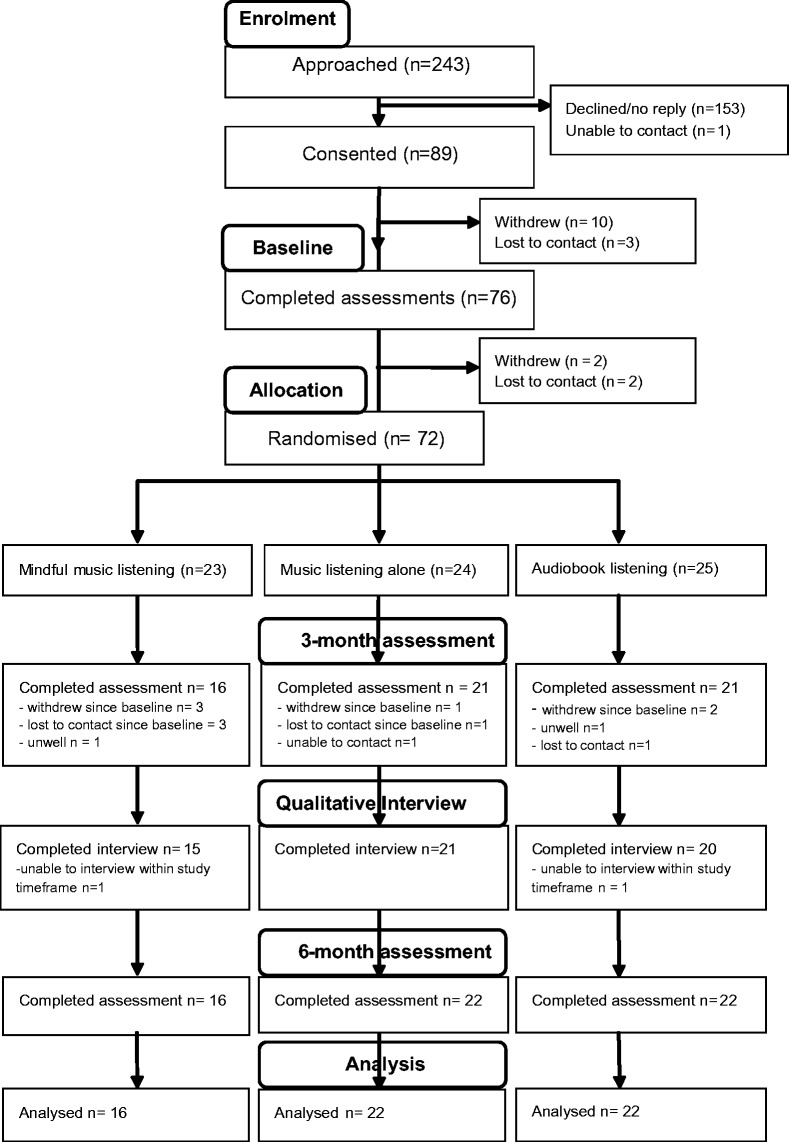
CONSORT Flowchart.